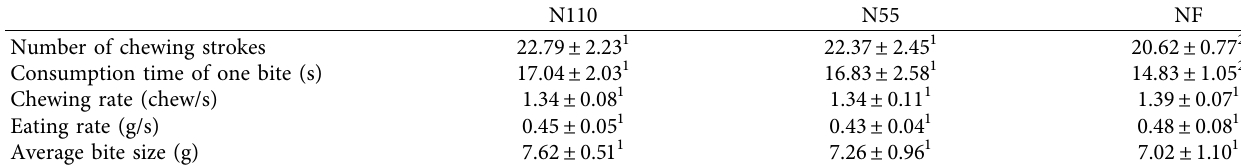
Table 3: Oral processing parameters of dry sausages formulated with different nitrite levels (mean ± standard deviation). N110